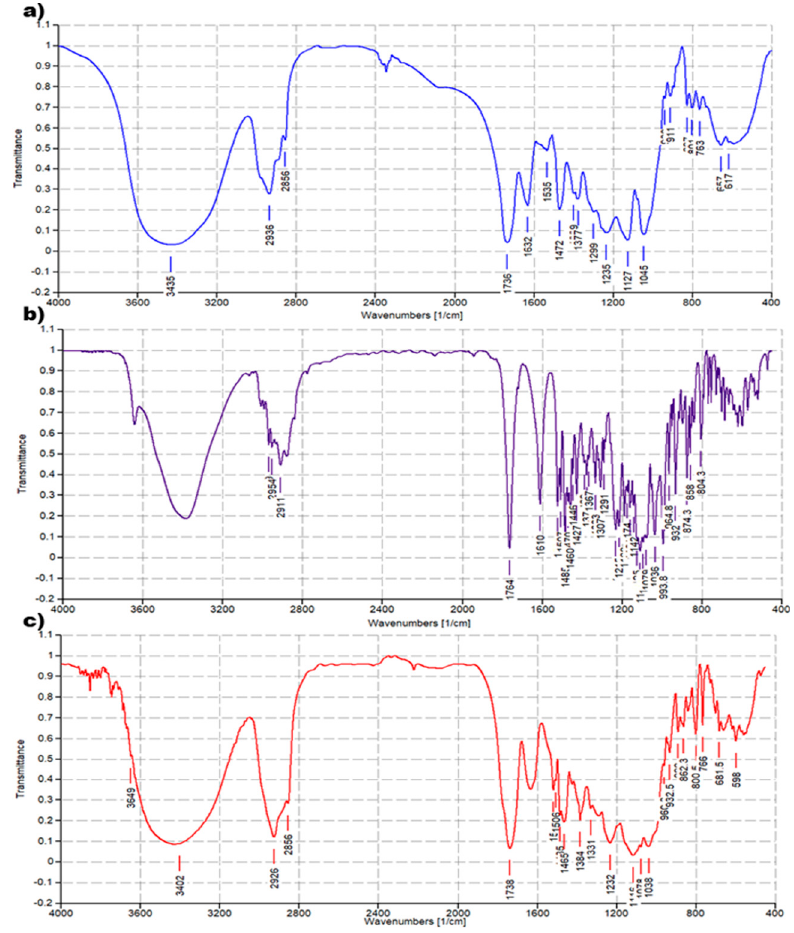
Figure 4. Comparison between FTIR spectrum of dendrimer 4 ( a ), ETO ( b ), and CPX 5 ( c ). ETO . FTIR (KBr, cm − 1 ): 1764, 1610, 1538, 1507, 1485, 1470, 1460, 1446, 1427, 1389, 1377, 1367,